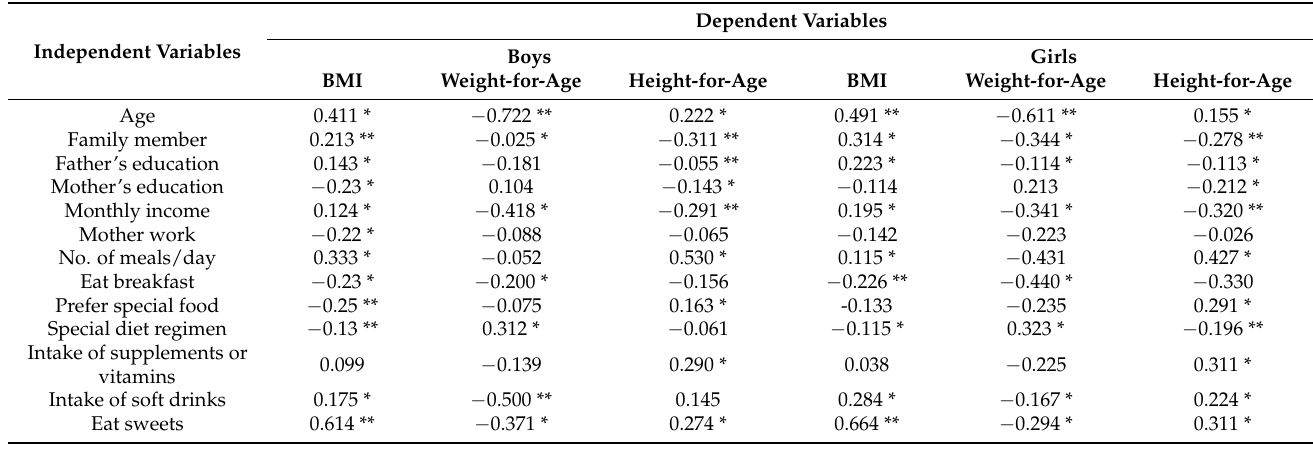
Table 6. Spearman correlation between socioeconomic characteristics, daily food habits, and the respondents’ anthropometric measurements of Syrian